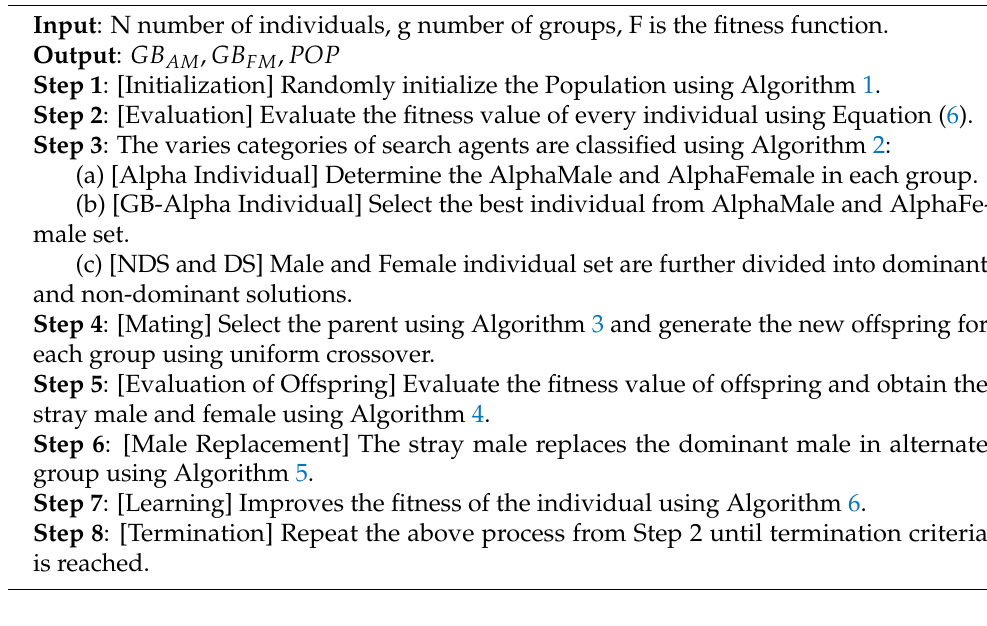
Algorithm 7 JMAD: Java Macaque Algorithm for Discrete